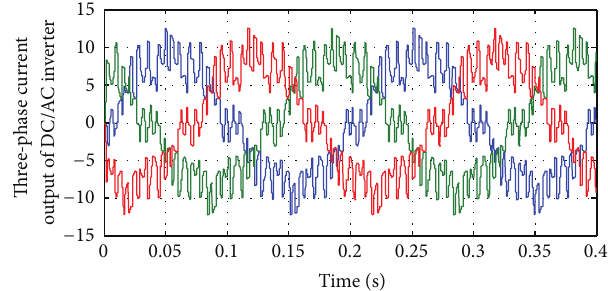
Figure 17: Inverter’s output current in worst case THD.